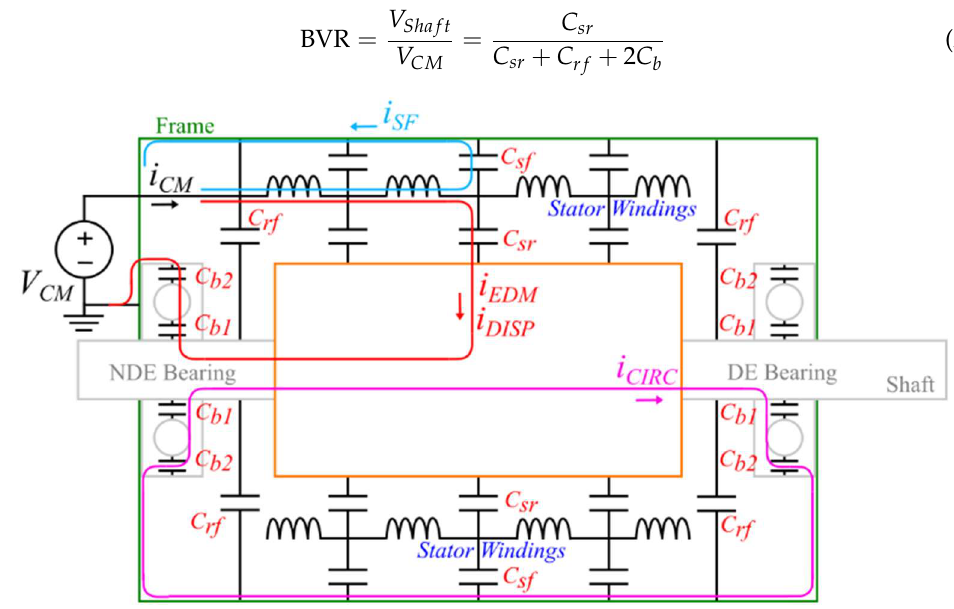
Figure 1. The high frequency components of the inverter CM voltage excite a CM current through the parasitic capacitive paths in a machine.